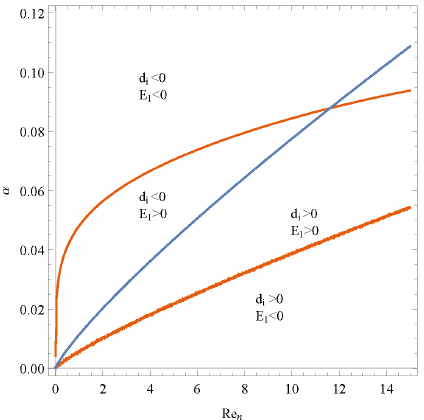
Fluids 2022 , 7 , x 12 of 15 Figure 6. Nonlinear neutral stability curves of the film flow for various α and Re at n = 1, Z = 0.